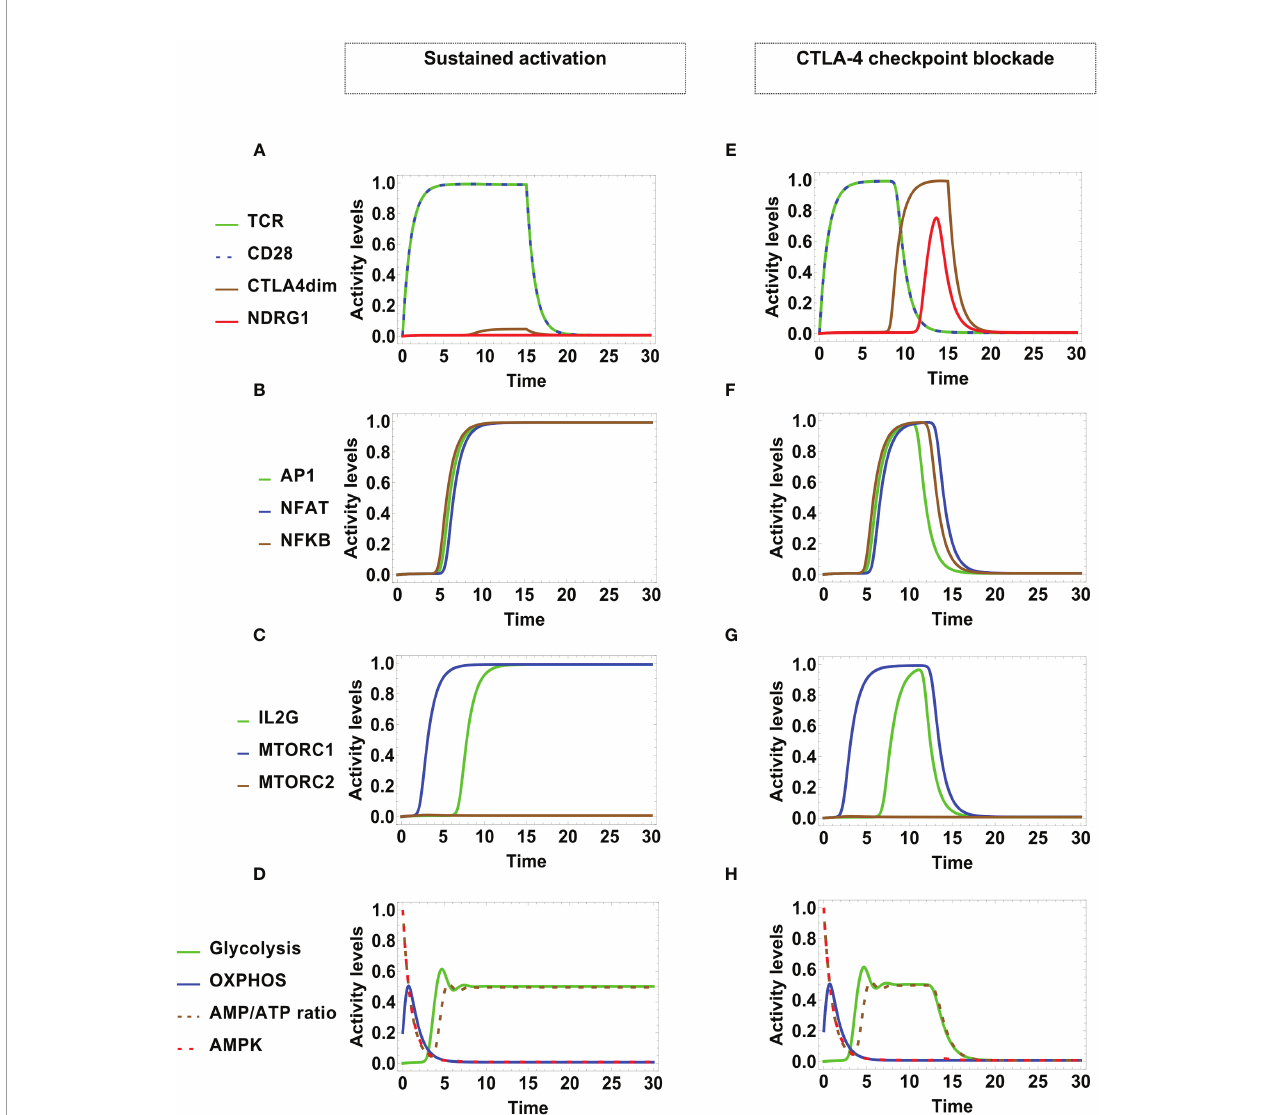
FIGURE 4 | Dynamics of transcription factors and metabolism under optimal engagement conditions of TCR with the MHC-antigen complex, and CD28 with CD80/ 86, during a stimulation time t MHC / A = t CD 8086 = 15 units. Left panel: Sustained T-cell activation associates to low-level activity of CTLA-4 (with high decay rated d CTLA 4 = 5). (A) TCR and CD28 are fully activated as far as antigenic stimulation persists, leading to (B) sustained expression of the transcription factors AP-1, NFAT, and NF k B, and (C) sustained expression of mTORC1 and IL-2. (D) Metabolic pro fi le: After initial activation, the AMP/ATP ratio decreases, leading to a reduction of the activity of the nutrient sensor AMPK and a temporary increment of OXPHOS. With the course of time, OXPHOS decays and glycolytic activity increases up to a steady level, in parallel with the AMP/ATP ratio. Right panel: Checkpoint blockade associated to high-level activity of CTLA-4 (with low decay rate d CTLA 4 = 0.5). (E) Initially, TCR and CD28 are fully activated. With the course of time, the expression level of dimerized CTLA-4 increases, displacing CD28 from co-stimulatory molecules, with the concomitant induction of anergy. This is manifested as (F) transitory expression and down-regulation of the activation transcription factors AP-1, NFAT, NF k B, and (G) transitory expression and down-regulation of mTORC1 and IL-2. (H) Metabolic pro fi le: At the beginning, the metabolic activity shows an identical pattern as in the case of sustained activation; eventually, the inhibitory action of CTLA-4 induces the decay of